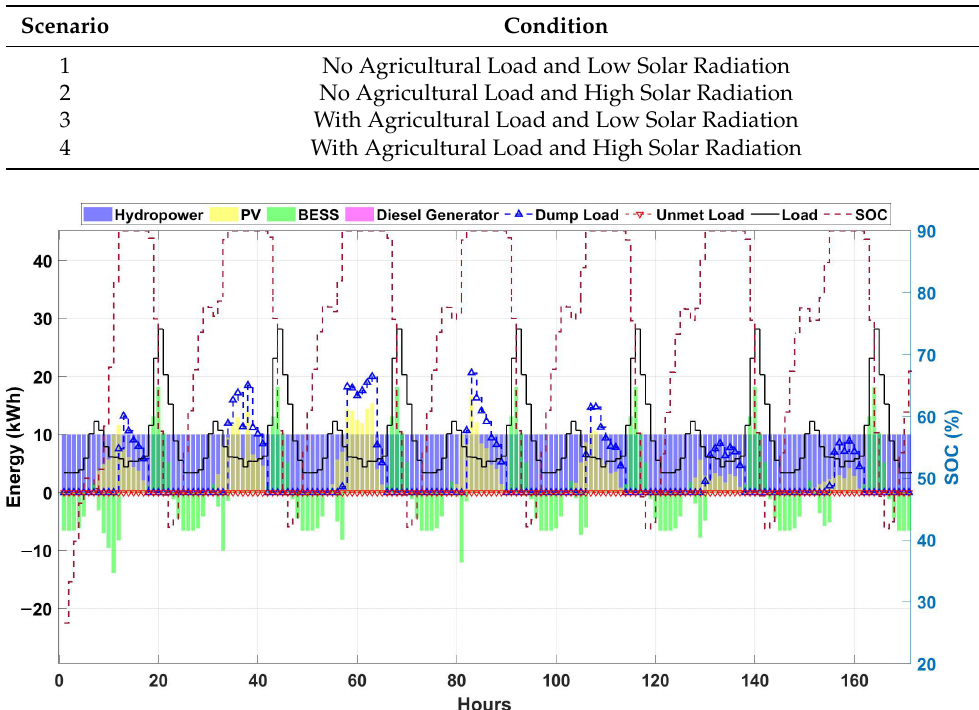
Table 8. Four scenarios for HREM scheduling analysis.